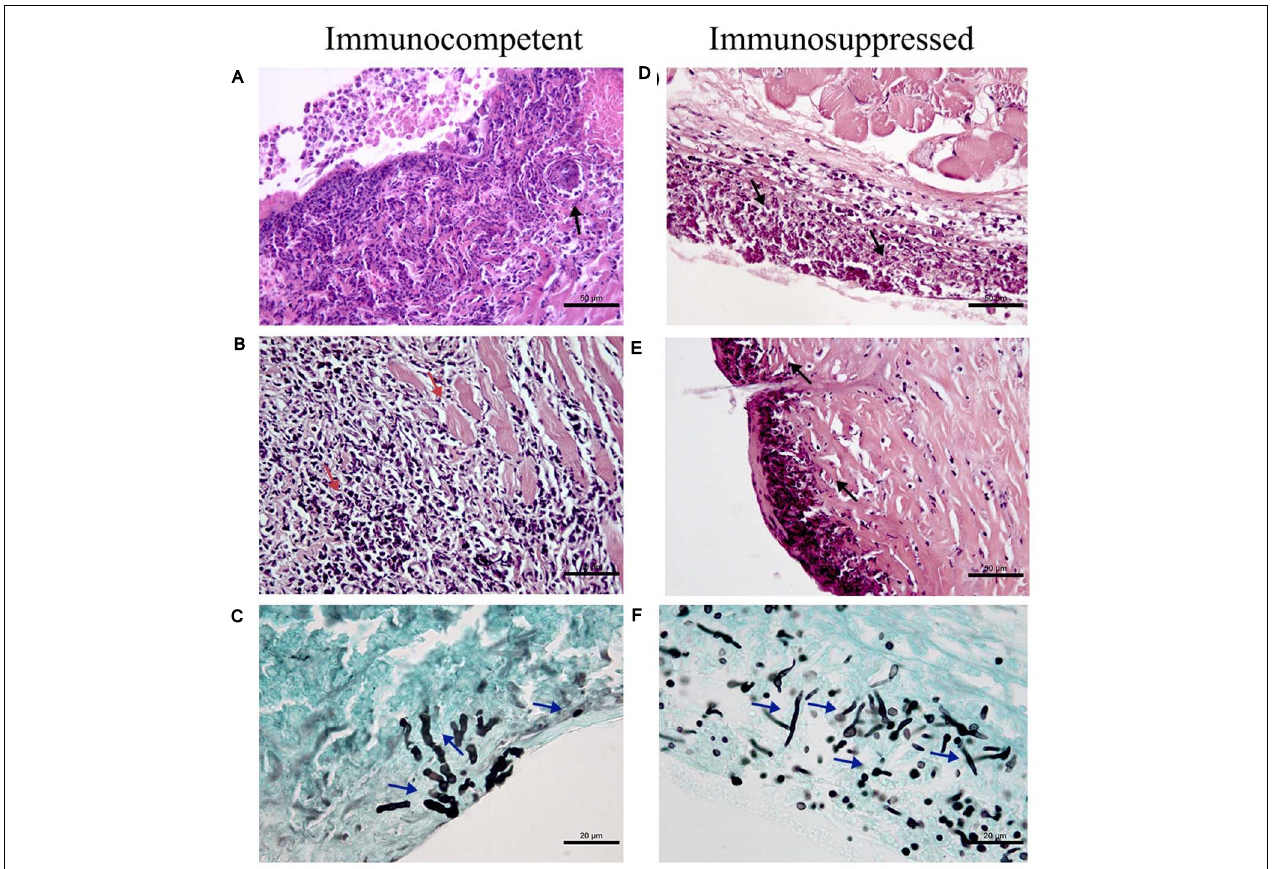
FIGURE 2 | Histological findings in the cutaneous and subcutaneous tissues of immunocompetent (CI–left column) and immunosuppressed mice (SI–right column) inoculated at the tail base with 1 × 10 5 conidia of Purpureocillium lilacinum . (A) Diffuse inflammatory infiltrate (black arrow) constituted mainly by macrophages and neutrophils reaching superficial and deep dermis on day 1 after infection, H&E. (B) Necrosis in the skeletal muscle and fibrosis in the dermis and subcutaneous tissue (red arrows) on day 5 after infection, H&E. (C) Hyphae in the dermis (blue arrows) on the third day after infection, Grocott. (D) Severe inflammatory infiltrate (black arrows) affecting the superficial and deep dermis and adjacent skeletal muscles on day 3 after infection, H&E. (E) Suppurative dermatitis and panniculitis (black arrows) with diffuse inflammatory infiltrate ranging from mild to severe consisting mainly of neutrophils, with fewer macrophages on day 7 after infection, H&E; (F) Abundant hyphae, pseudohyphae (blue arrows) in the subcutaneous tissue on day 1 after inoculation,